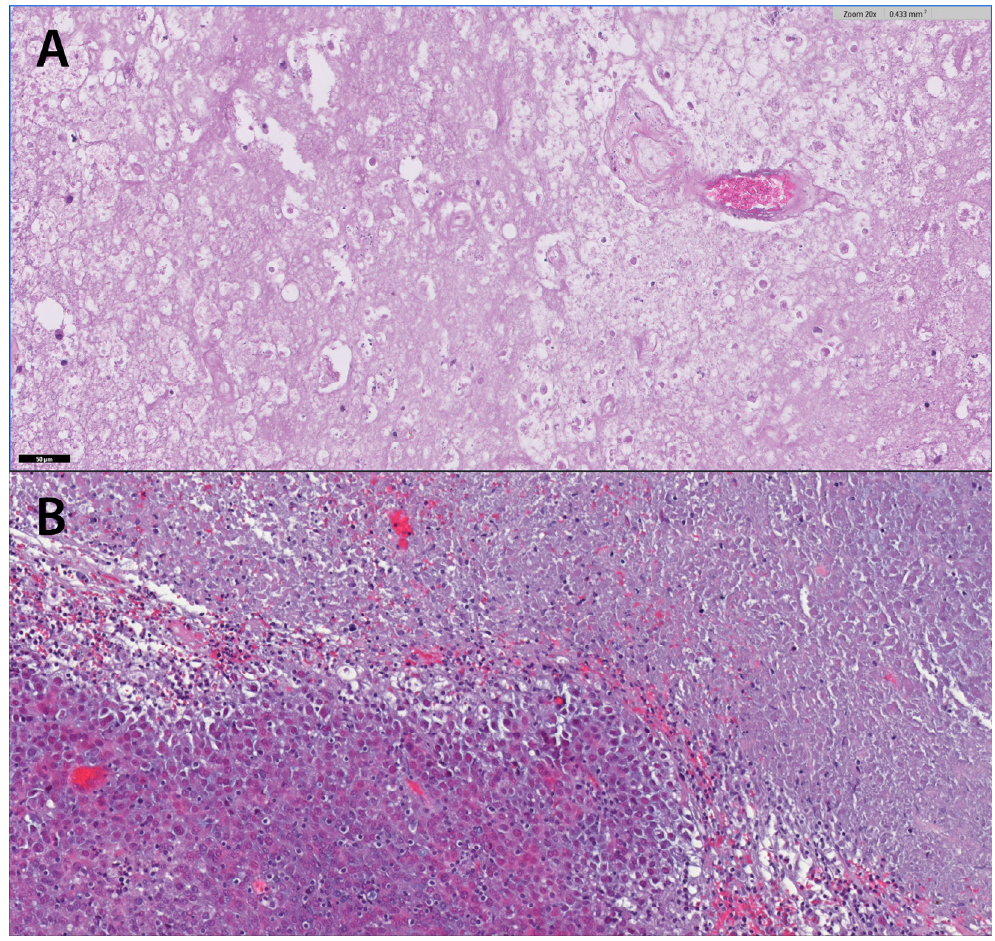
Figure 5. ( A ): Typical appearance of an RN in a patient treated due to progressive CE mass after resection and focal radiotherapy for a melanoma BM. Necrotic areas and shadows of vessels without tumor cells. HE staining 20×. ( B ): Necrotic tissue adjacent to vital tumor cells with eosinophilic cytoplasm in a patient with NSCLC. Tumor cell nuclei are variable in size. HE staining.